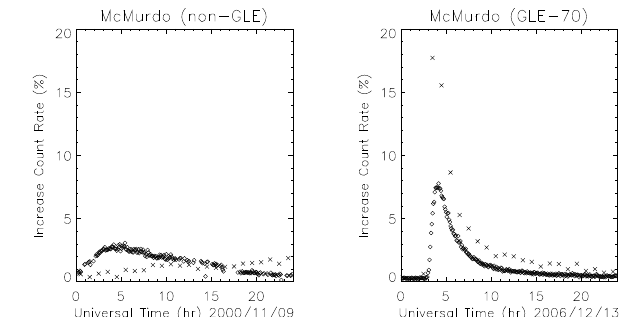
Figure 2. Simulated (diamonds) and observed (crosses) increase count rate at the McMurdo neutron monitor during the non-GLE SEP event (left) and during the GLE-70 event (right).